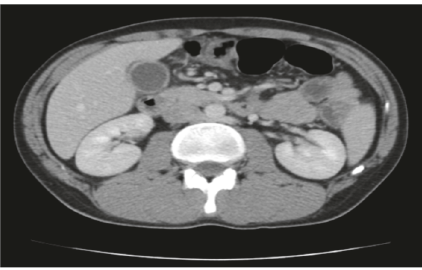
Figure 4: CT-scan of the abdomen showing thickening of the gallbladder wall and pericholecystic fluid